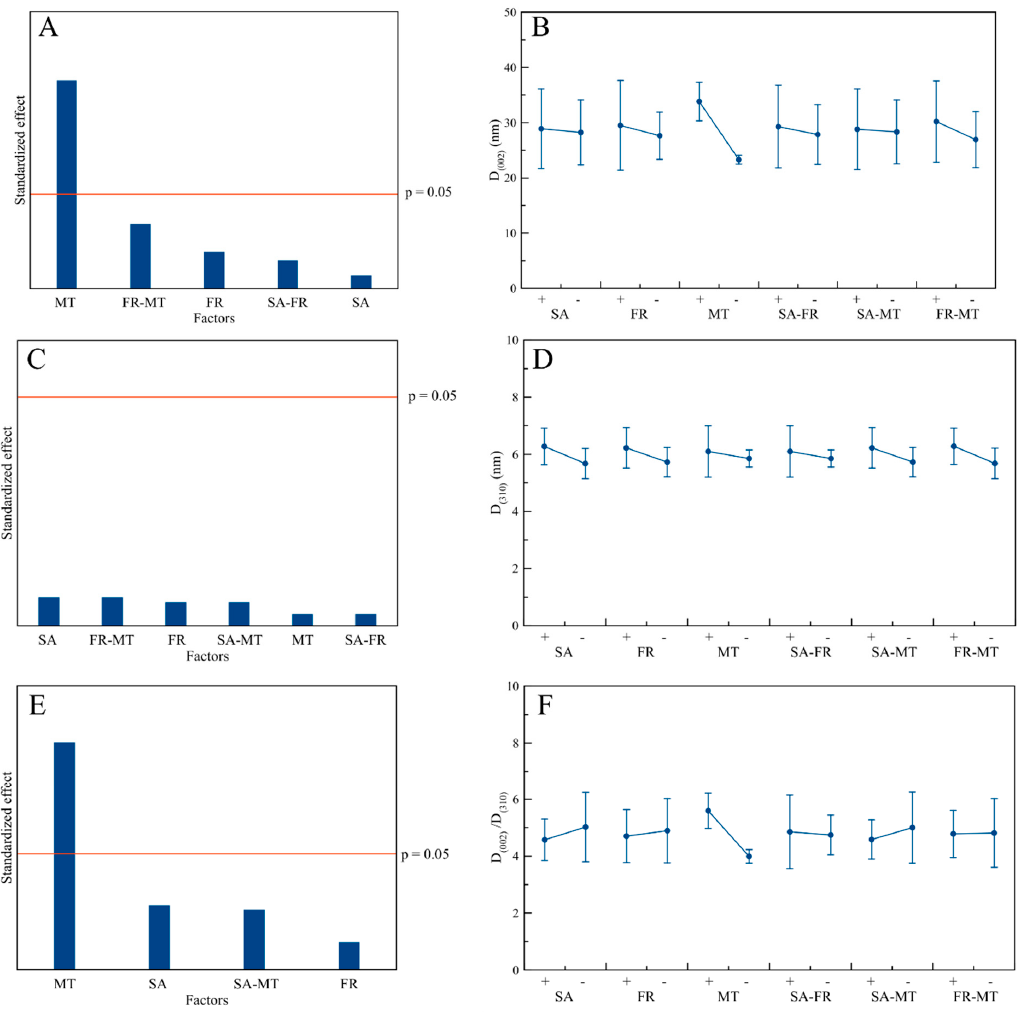
Figure 3. ( A , C , E ) Pareto chart of relevant standardized effects at the confidence limit of 95% and ( B , D , F ) plot of marginal means for ( A , B ) the D (002) crystalline domain, ( C , D ) the D (310) crystalline domain, and the ( E , F ) D (002) /D (310) ratio.